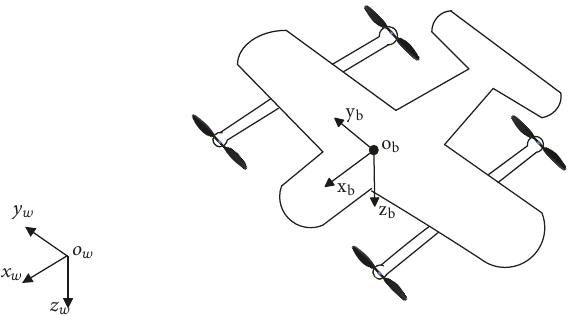
Figure 4: The inertial coordinate and body